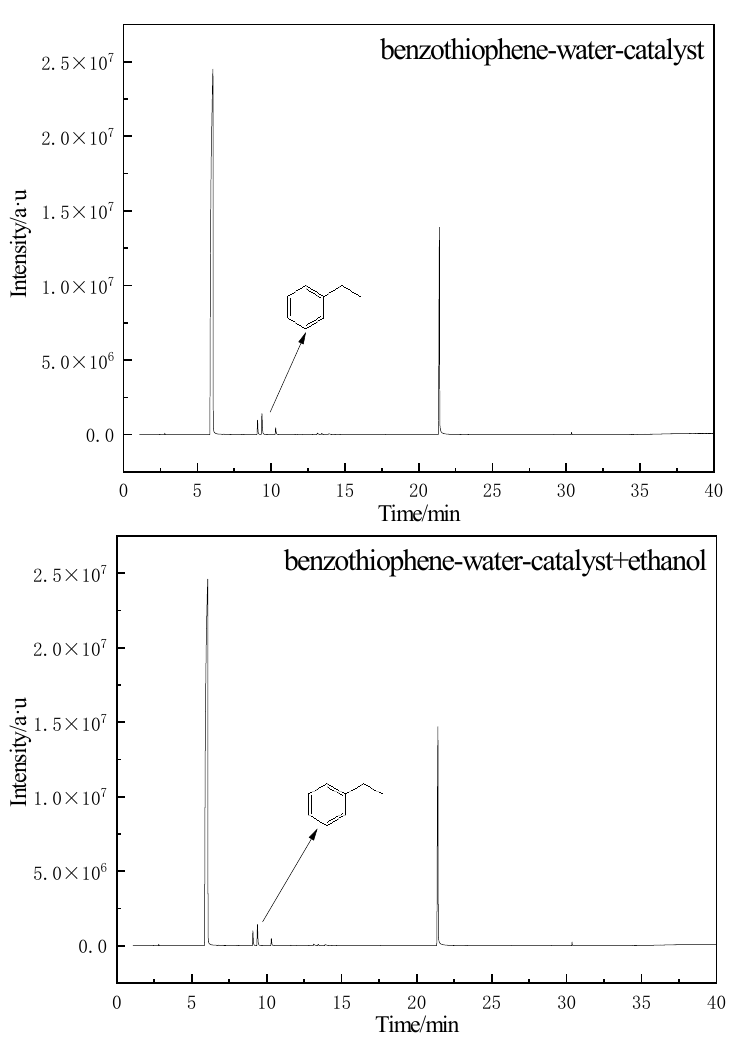
Figure 16. GC curves of benzothiophene after reaction under different reaction conditions.